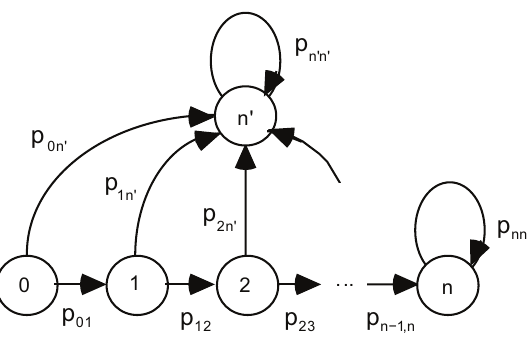
figure 1. sales transition